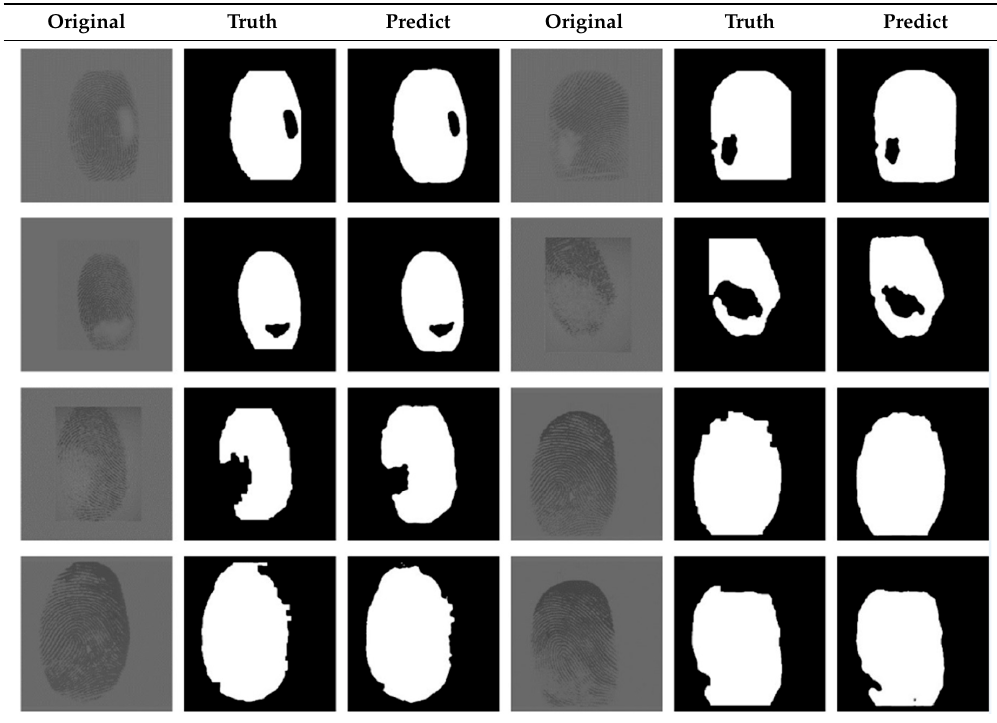
Table 3. Forward reasoning results of training set and validate set.